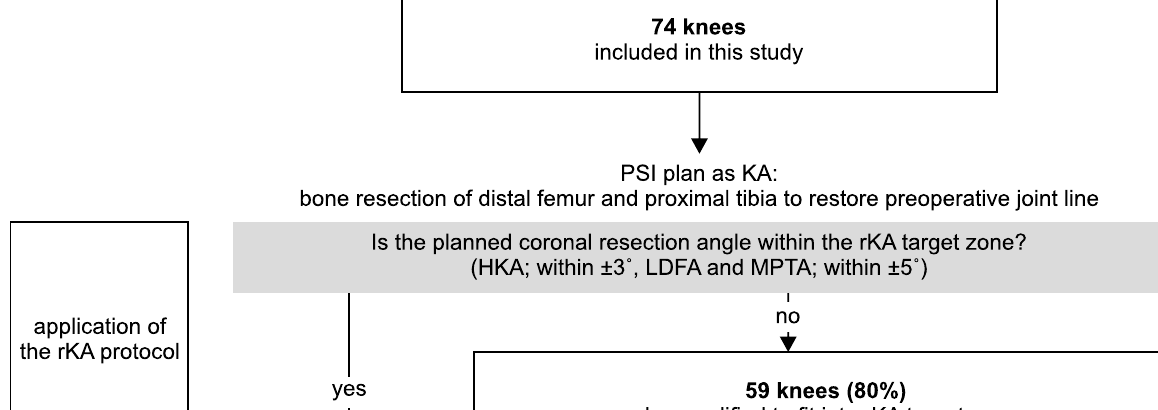
Table 1 Measurements of preoperative, planned, and postoperative alignments and MAE between the planned and postoperative alignments